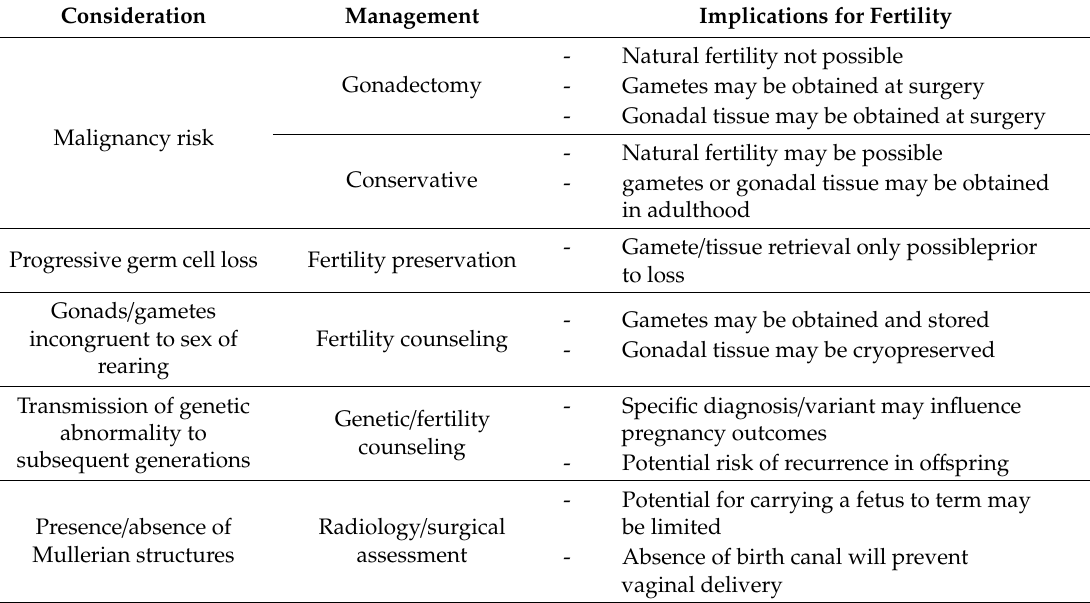
Table 1. Key considerations for fertility and fertility preservation in